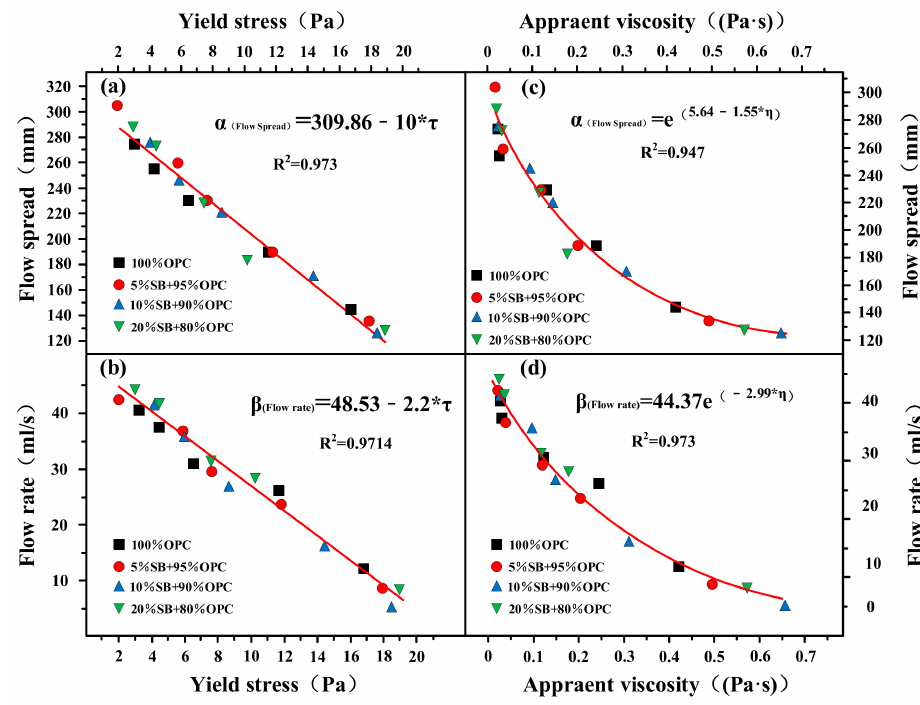
Figure 10. Flow rate and flow spread versus apparent viscosity ( c , d ) and yield stress ( a , b ). The flow rate and flow spread are shown as functions of 1 day, 7 days, and 28